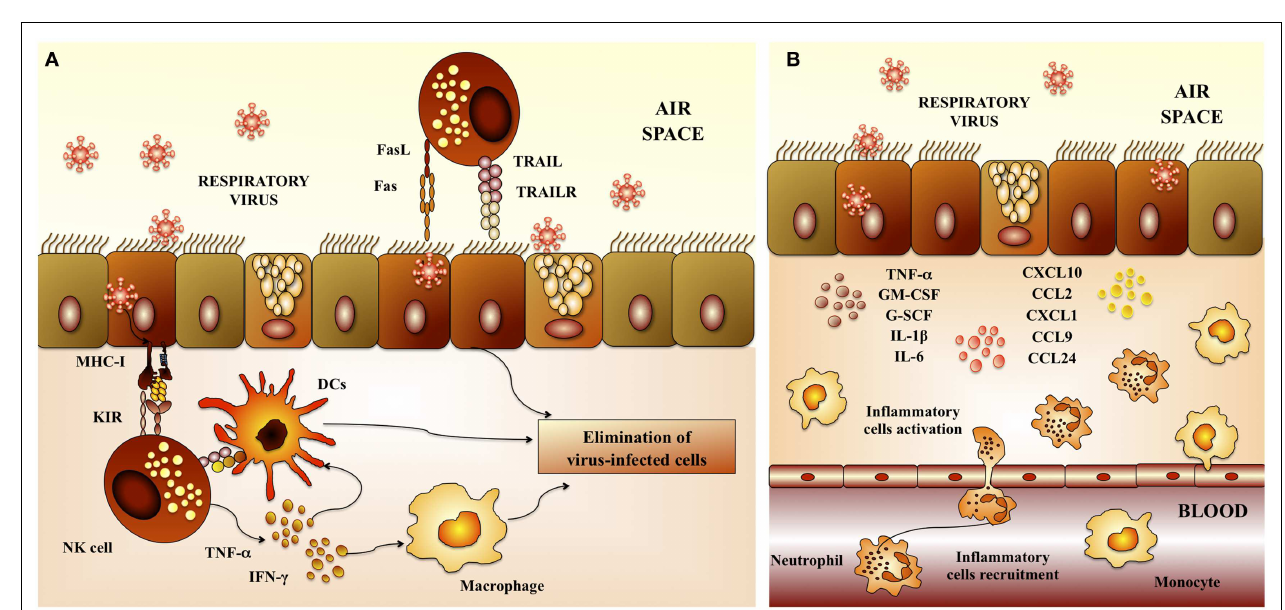
IL-8/CXCL8, IP-10/CXCL10, MCP-1/CCL2, MIP-1a/CCL3, MIP-1b/CCL4, RANTES/CCL5, IL-6,TNF, and IL-1 are produced by epithelial cells and macrophages in response to virus infection. Upregulation of these cytokines and leads to recruitment of neutrophils, which constitute the majority of infiltrating cells.While neutrophils may mediate elimination of virus-infected cells, their high numbers, ability to secrete further cytokines and chemokines, and degranulation products may contribute to respiratory virus-induced immunopathogenesis.